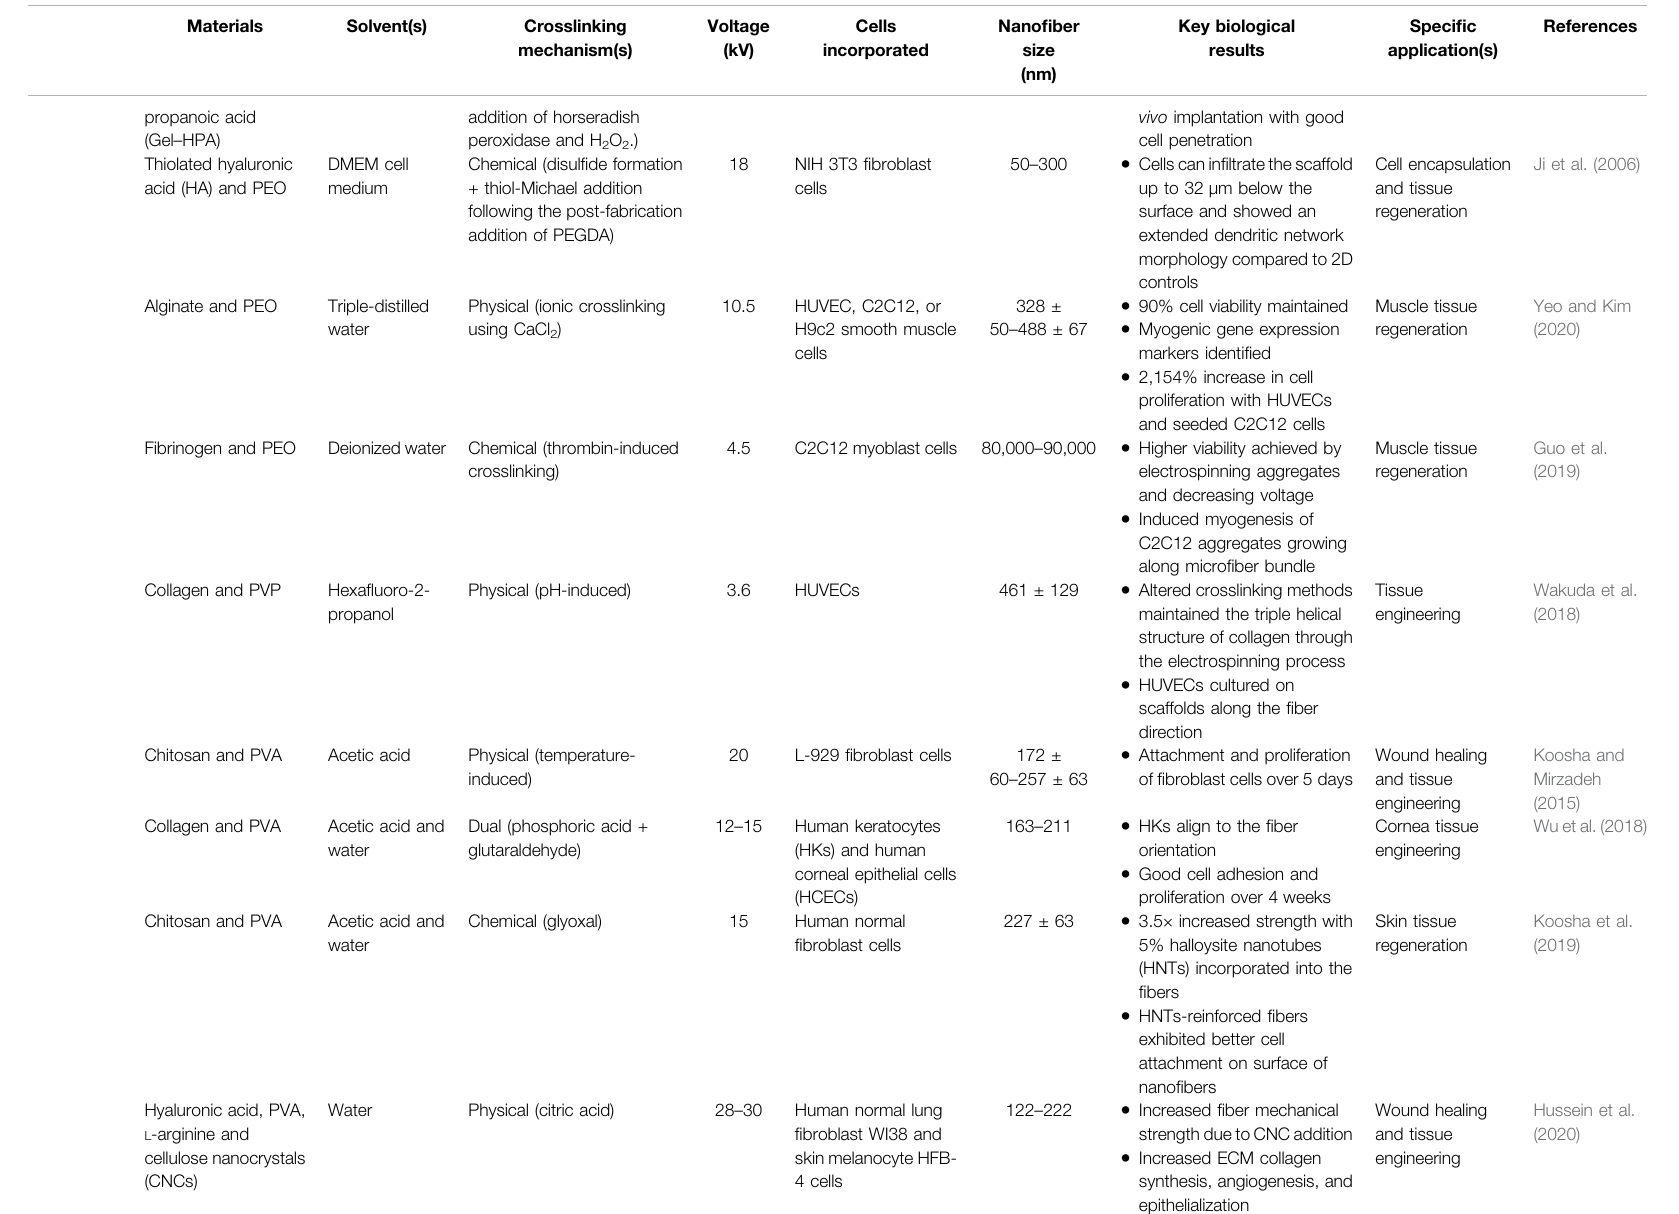
TABLE 1 | ( Continued ) Materials and methods used for electrospinning hydrogels for tissue